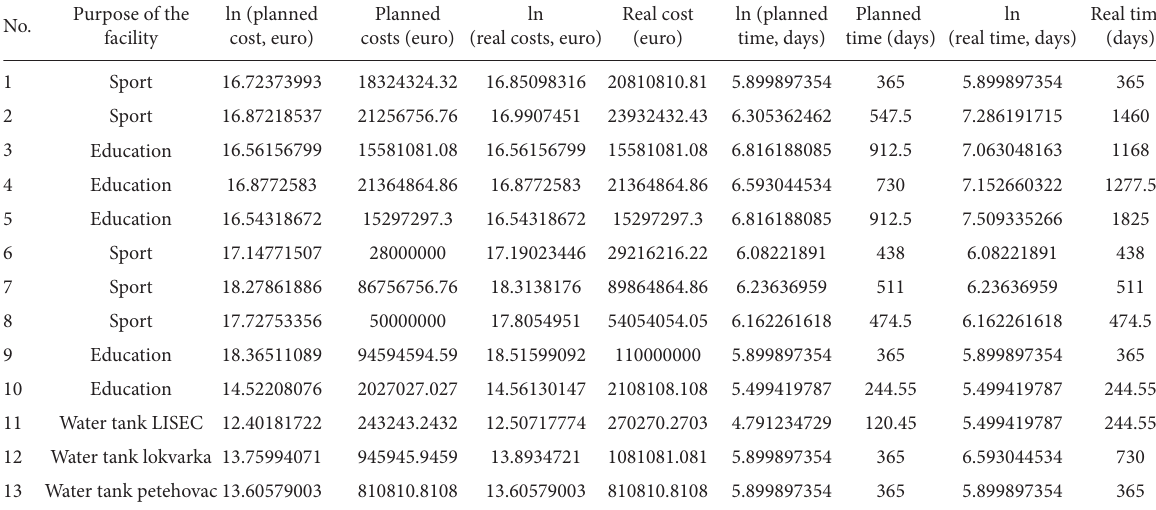
Figure 6: Part of the input data (13 rows, from 116) used for